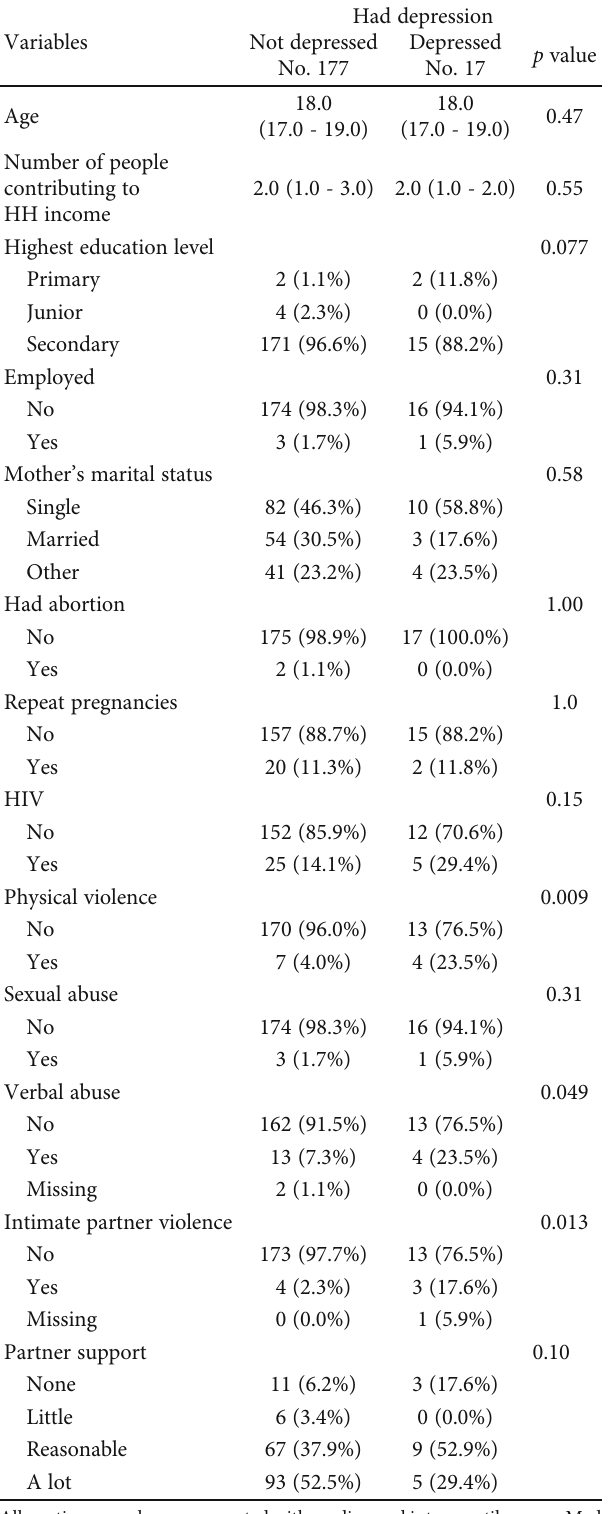
Table 6: Comparison of risk factors for participants who speci fi cally had depression versus those who did not in the postpartum period ( n = 194